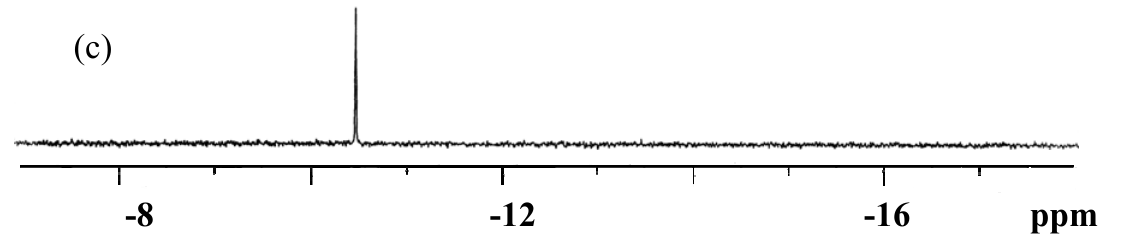
Figure 5. 31 P-NMR spectra of (a) K 0.1 M aqueous HCl, (b) K 0.5 M aqueous H D 2